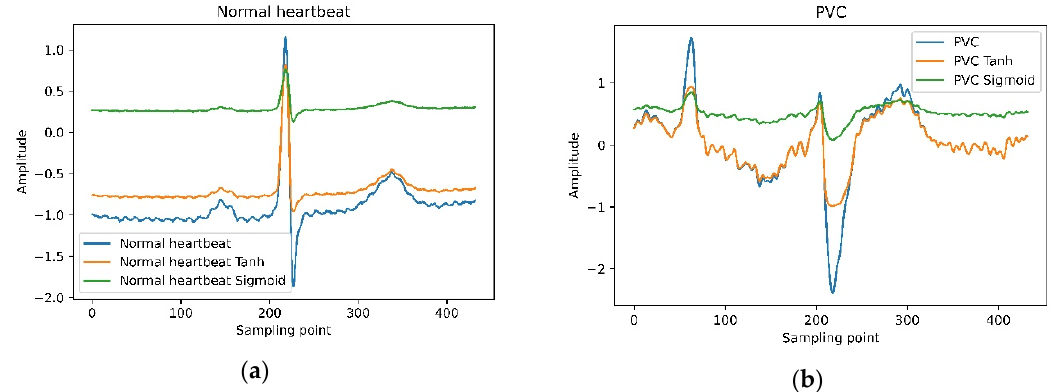
Figure 7. Tanh and Sigmoid normalize the waveform of a normal heartbeat and PVC.